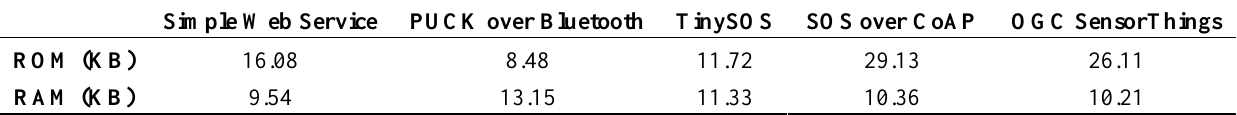
Table 1. RAM and ROM memory